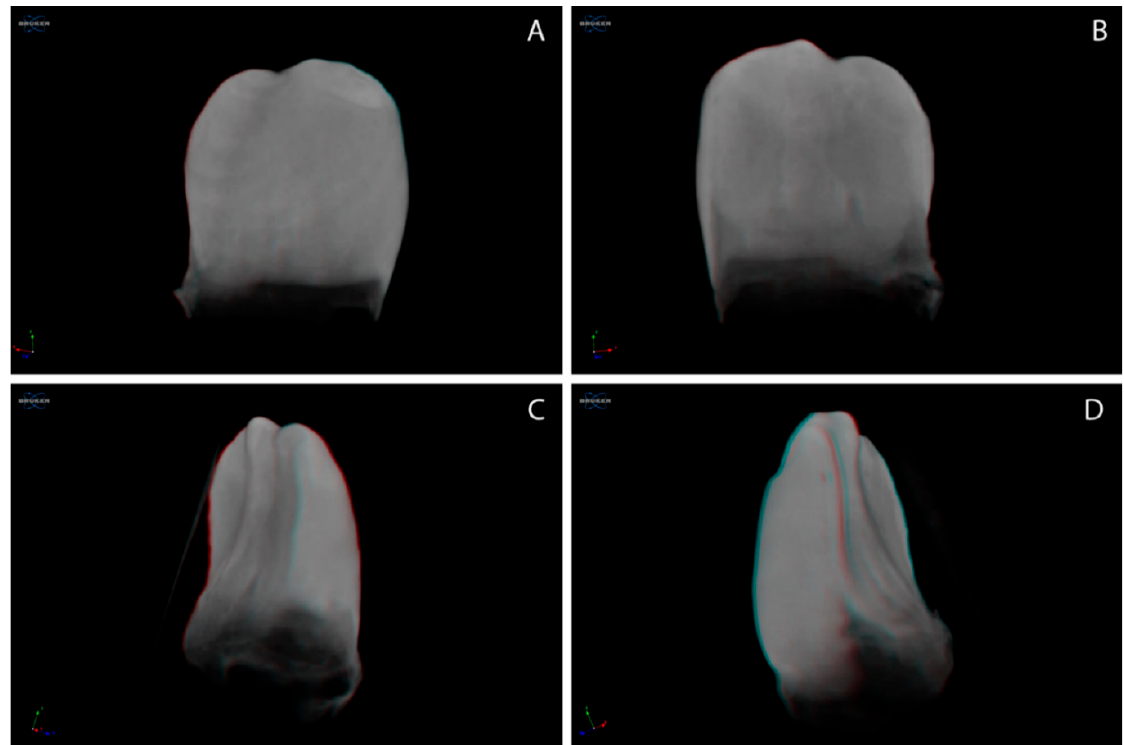
Figure 1. Representative 3D reconstructed natal tooth. ( A ) buccal view; ( B ) palatal view; ( C , D ) proximal views.